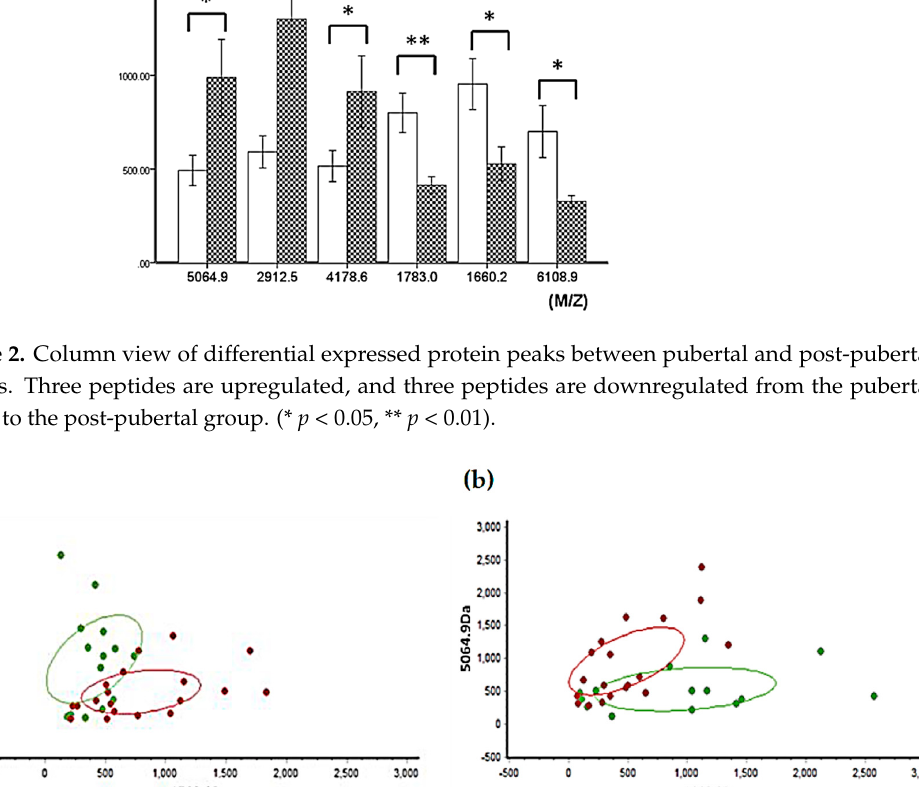
Figure 3. Scatter plots established by the combination of peptides 1783.0 Da and 5064.9 Da ( a ); 1660.2 Da and 5064.9 Da ( b ). Green plots represent pubertal group and red plots represent post-pubertal group.